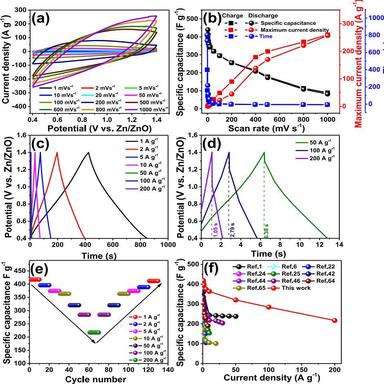
Electrochemical performances of the as-prepared TPC electrode: (a) CV curves at different scan rates, (b) detailed electrochemical parameters from CV test, (c,d) GCD curves at different current densities, (e) Rate performance of TPC at different CDs and (f) comparison of SCs of TPC electrode with other reported bio-waste based carbon materials.